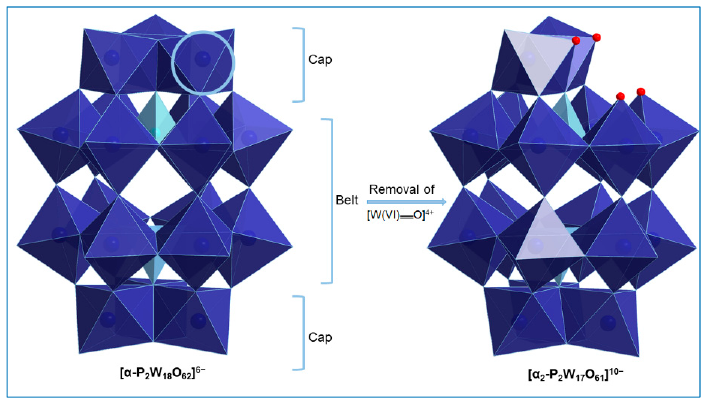
Figure 2. Formation of the [ α 2 -P 2 W 17 O 61 ] 10 − isomer by removal of a [W(VI) ══ O] 4+ unit from the “cap” segment of the parent [ α - P 2 W 18 O 62 ] 6 − anion. Color code: WO 6 blue octahedra, PO 4 sky blue tetrahedra, O red spheres.